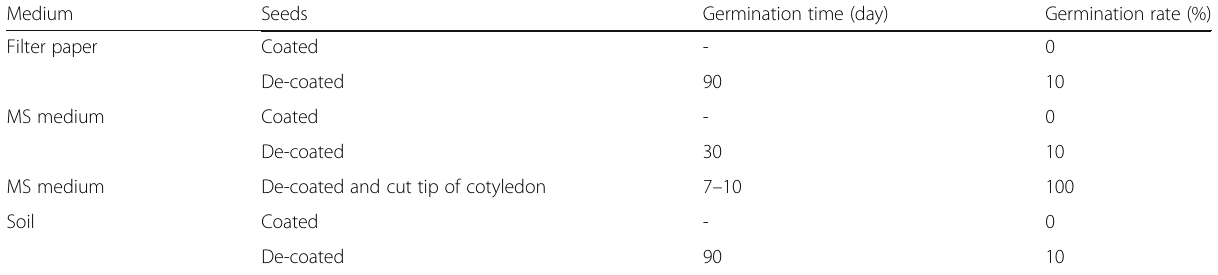
Table 2 Seed germination rate of S. longipedunculata under different growth conditions Medium